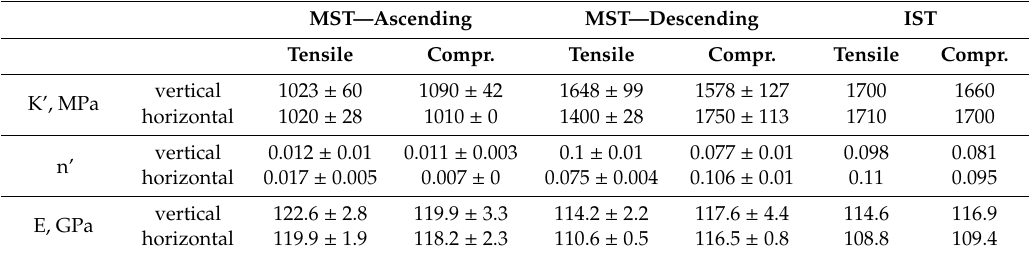
Table 7. Analytical description of the cyclic stress-strain curves determined from multiple step tests and incremental step tests for vertically and horizontally oriented